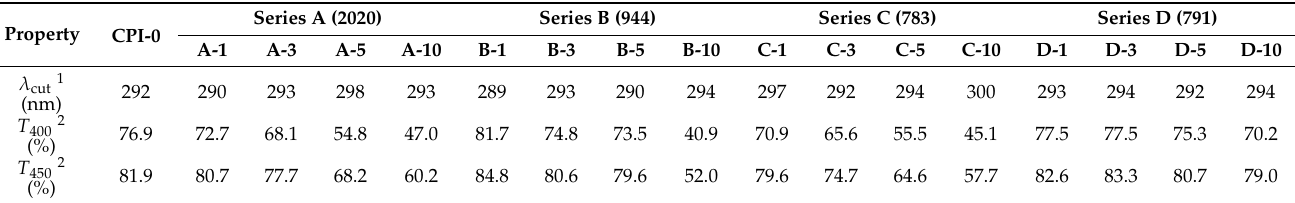
Table 4. Optical properties of CPI/HALS nanocomposite films.